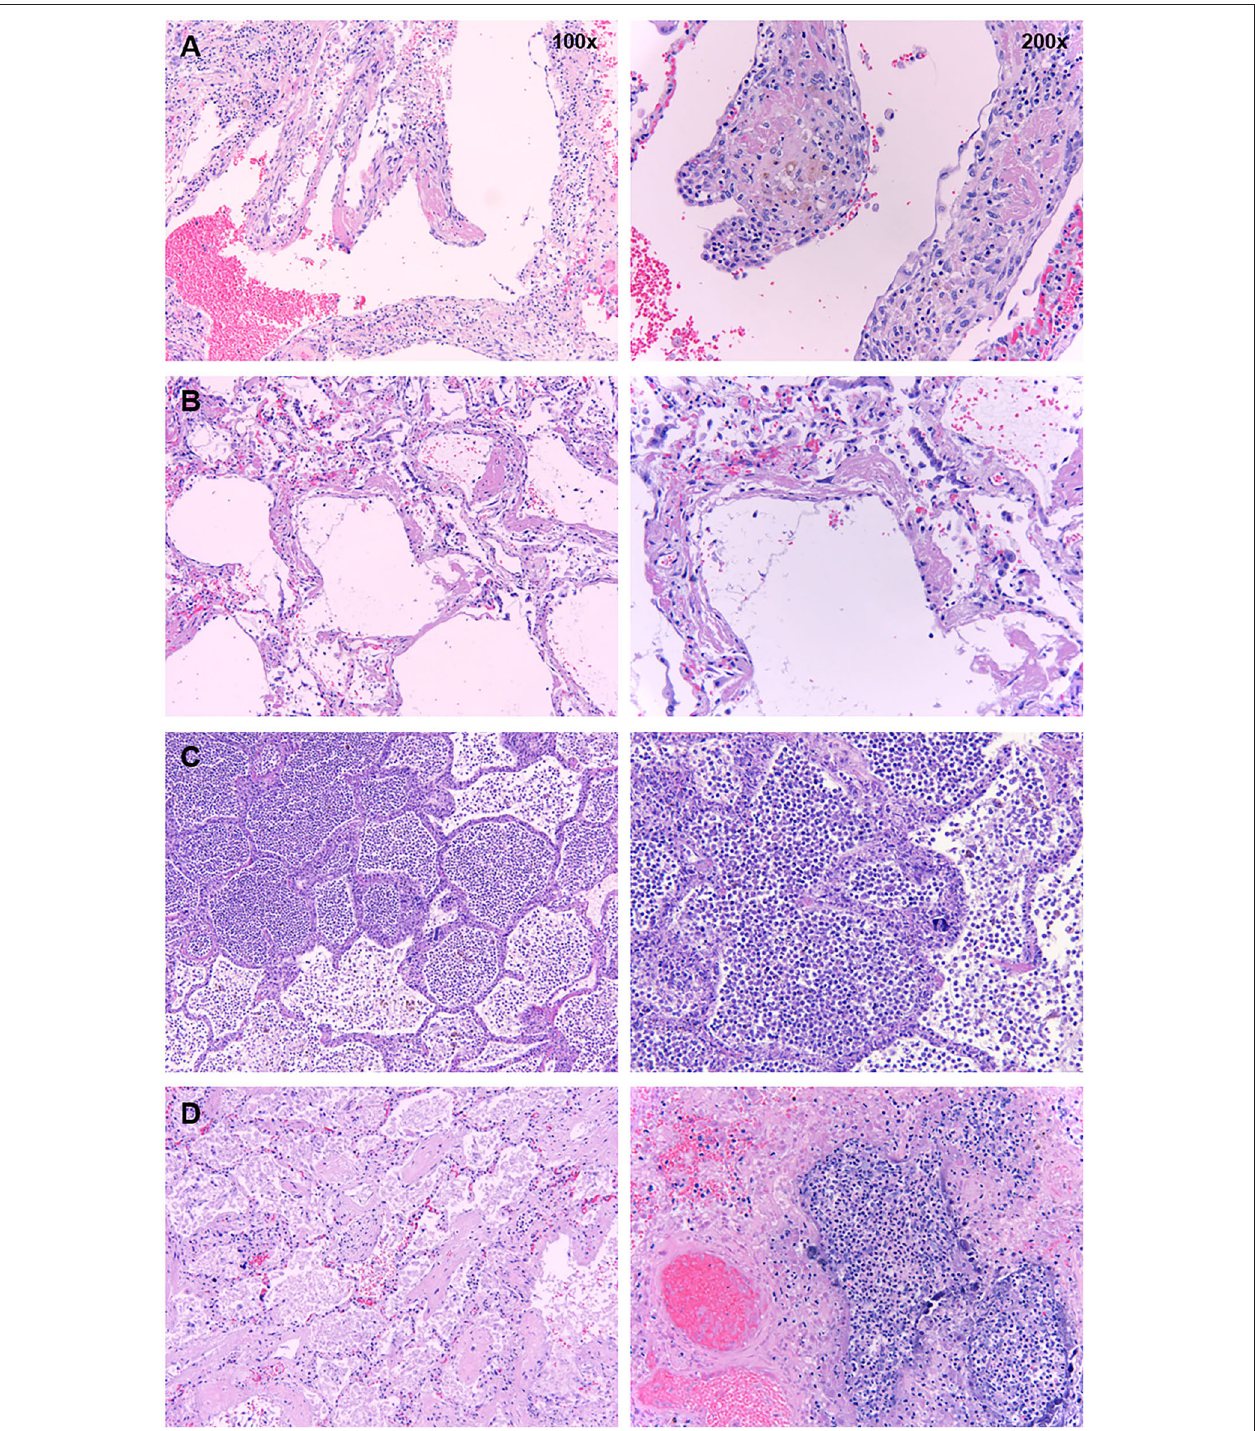
FIGURE 2 | Post-mortem histopathology of lungs from COVID-19 patients. Low- ( × 100) and high-power ( × 200) images of lungs from patients who died due to COVID-19. (A) Organizing hyaline membranes are seen in the lung which has pre-existing emphysema ( × 100). Higher power shows fibrin, fibroblasts, and mononuclear cells incorporated into the alveolar walls ( × 200). (B) There is diffuse alveolar damage with hyaline membranes lining alveoli ( × 100). Higher power shows minimal inflammation with only a few mononuclear cells ( × 200). (C) There is extensive intra-alveolar inflammation (neutrophils) in an otherwise normal lung ( × 100). On higher power, there is minimal alveolar wall thickening by inflammatory cells (also mainly neutrophils on myeloperoxidase staining and only rare lymphocytes) ( × 200). (D) Majority of the sections from this case show organizing intra-alveolar fibrin ( × 100). Several foci of acute inflammation with alveolar filling are present, as seen here on higher power